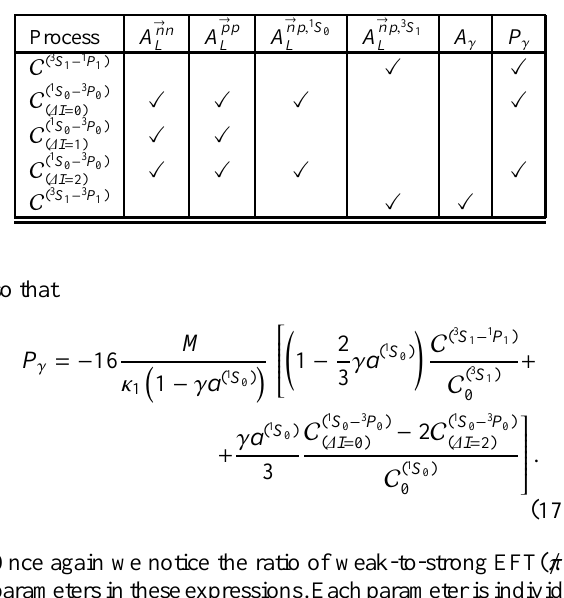
Table 1. The list of two-nucleon parity violating “observables” π ) coe ffi cients from Eqn. 5 they depend upon. and the PV EFT( 6 A → nn and A → pp depend upon the same set of parameters, but in dif- L L ferent linear combinations. The energy dependence of the A → np , 1 S 0 and A → np , 3 S 1 is di ff erent. A γ is defined in Eqn. (9). P γ is defined in L Eqn.